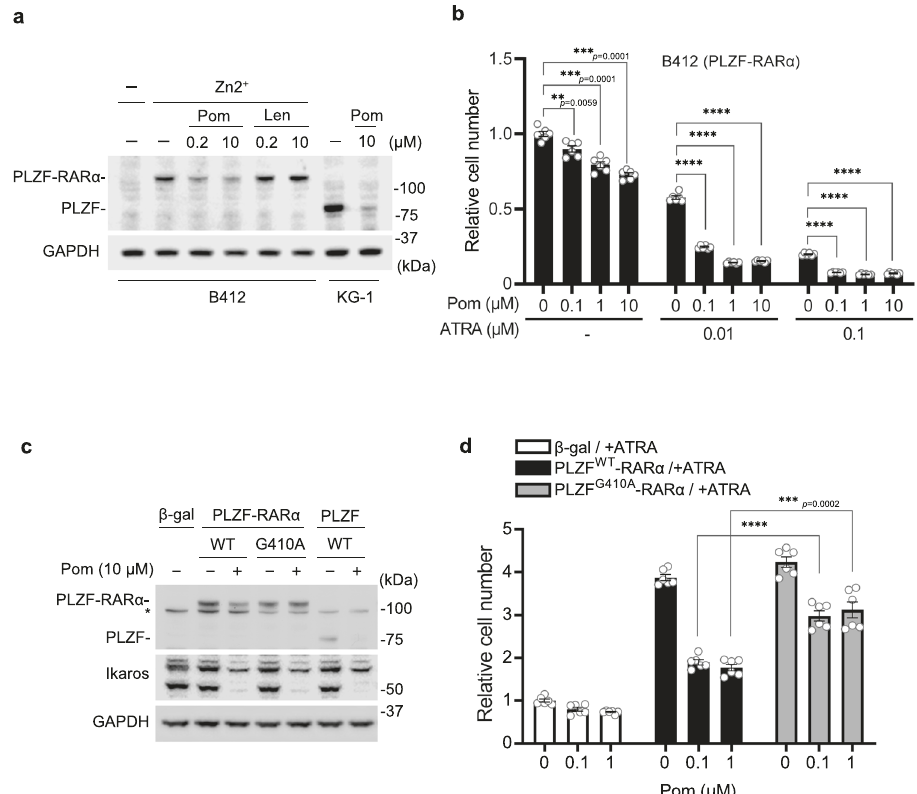
Fig. 5 Antiproliferative effect of pomalidomide on cells expressing PLZF-RAR α . a B412 and KG-1 cells were treated with lenalidomide or pomalidomide for 48 h. Where indicated, 100 μ M ZnSO4 (Zn 2 + ) was added 6 h prior to drug treatment. Cells were harvested and analyzed by immunoblotting. b The effect of pomalidomide on the proliferation of B412 cells. To B412 cells induced to express PLZF-RAR α by ZnSO 4 , pomalidomide and ATRA were added 6 days prior to cell counting. Data are shown as mean ± SEM from six biologically independent samples. ** p < 0.01; *** p < 0.001; **** p < 0.0001. Statistical signi fi cance was calculated with a two-way ANOVA with multiple comparisons test. c U937 cells expressing the indicated constructs were treated with pomalidomide or left untreated for 24 h, harvested, and subjected to immunoblotting. Asterisk denotes nonspeci fi c signal. d U937 cells expressing the indicated constructs were treated with ATRA and the indicated concentrations of pomalidomide for 7 days prior to cell counting. Data are shown as mean ± SEM from six biologically independent experiments. *** p < 0.001; **** p < 0.0001. Statistical signi fi cance was calculated with two-way ANOVA with multiple comparisons test. Experiments were conducted more than twice with similar